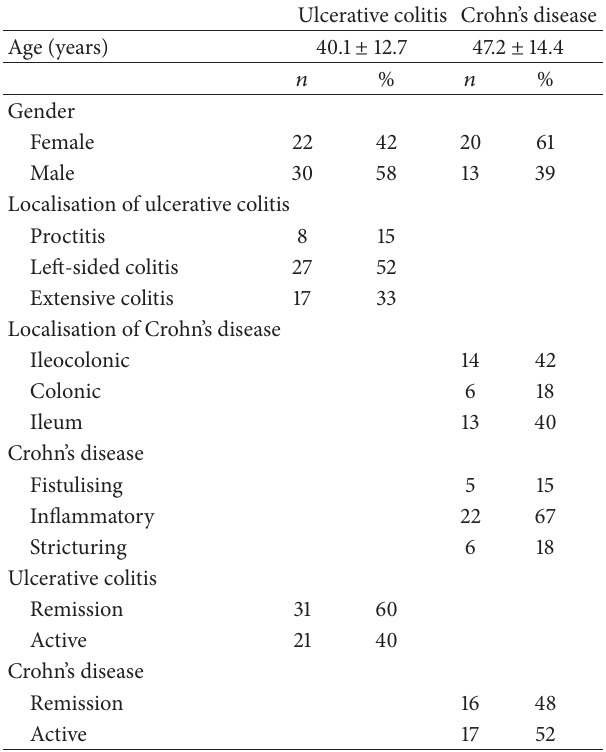
Table 1: Clinical and demographic characteristics of inflammatory bowel disease patients.